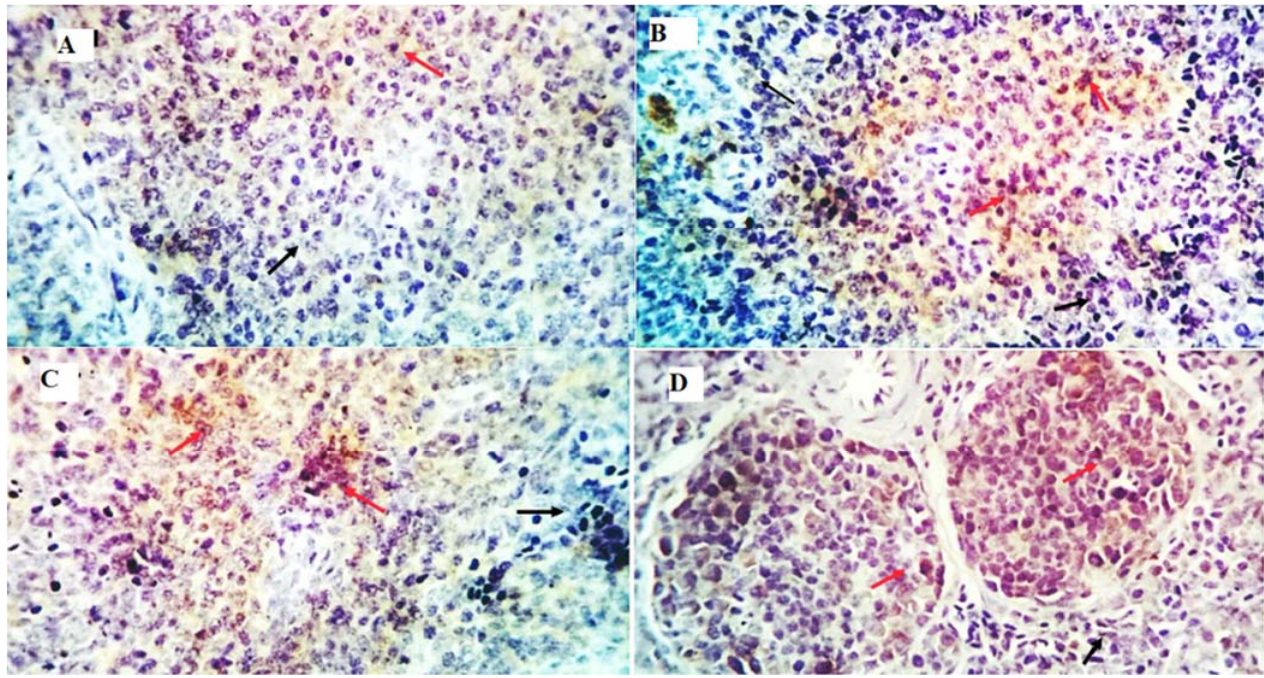
Figure 5. Immunostaining showing positive (red arrows) and negative (black arrows) CD20 cells in the spleen of broilers from different experimental groups. ( A ) FO0; ( B ) FO200; ( C ) FO400; ( D ) FO600.